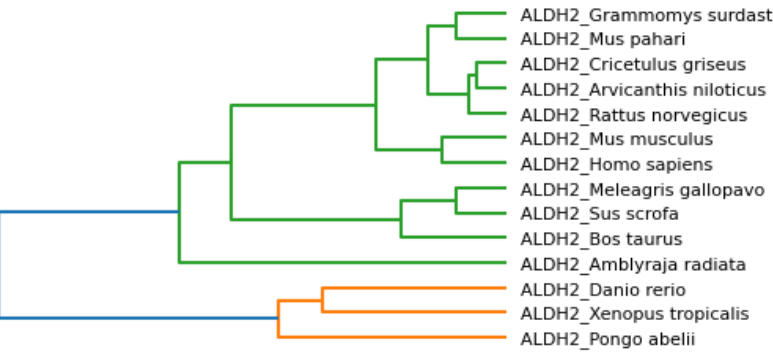
Figure 8. Hierarchical clustering phylogenetic tree based on secondary structure.